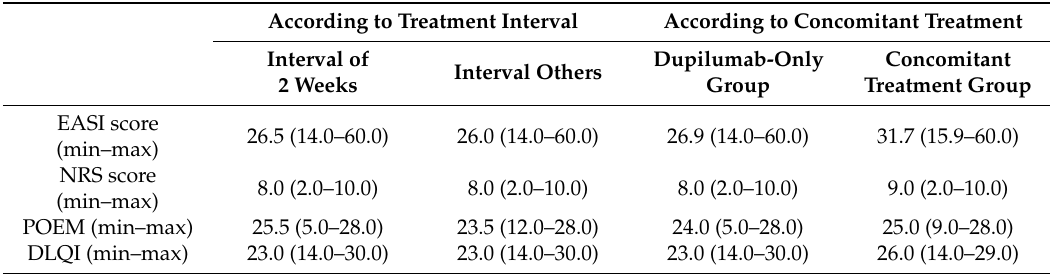
Table 7. Baseline characteristics in subgroup